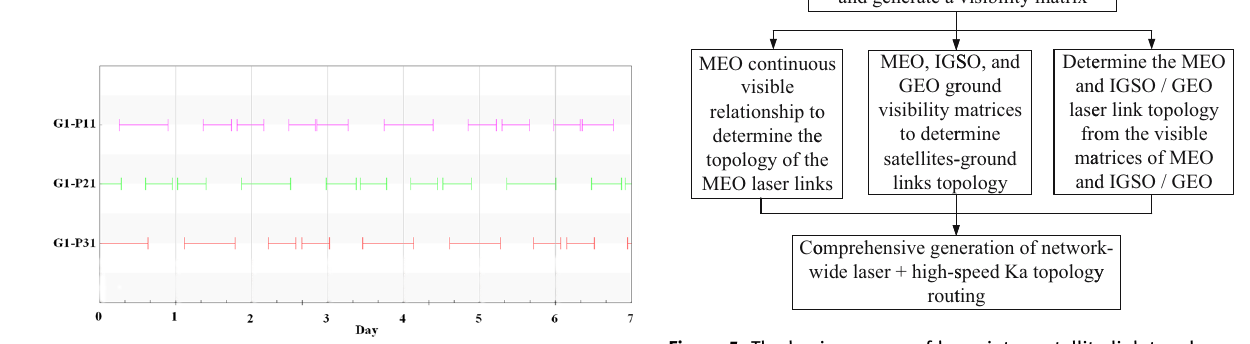
Figure 5: The basic process of laser inter - satellite link topology routing